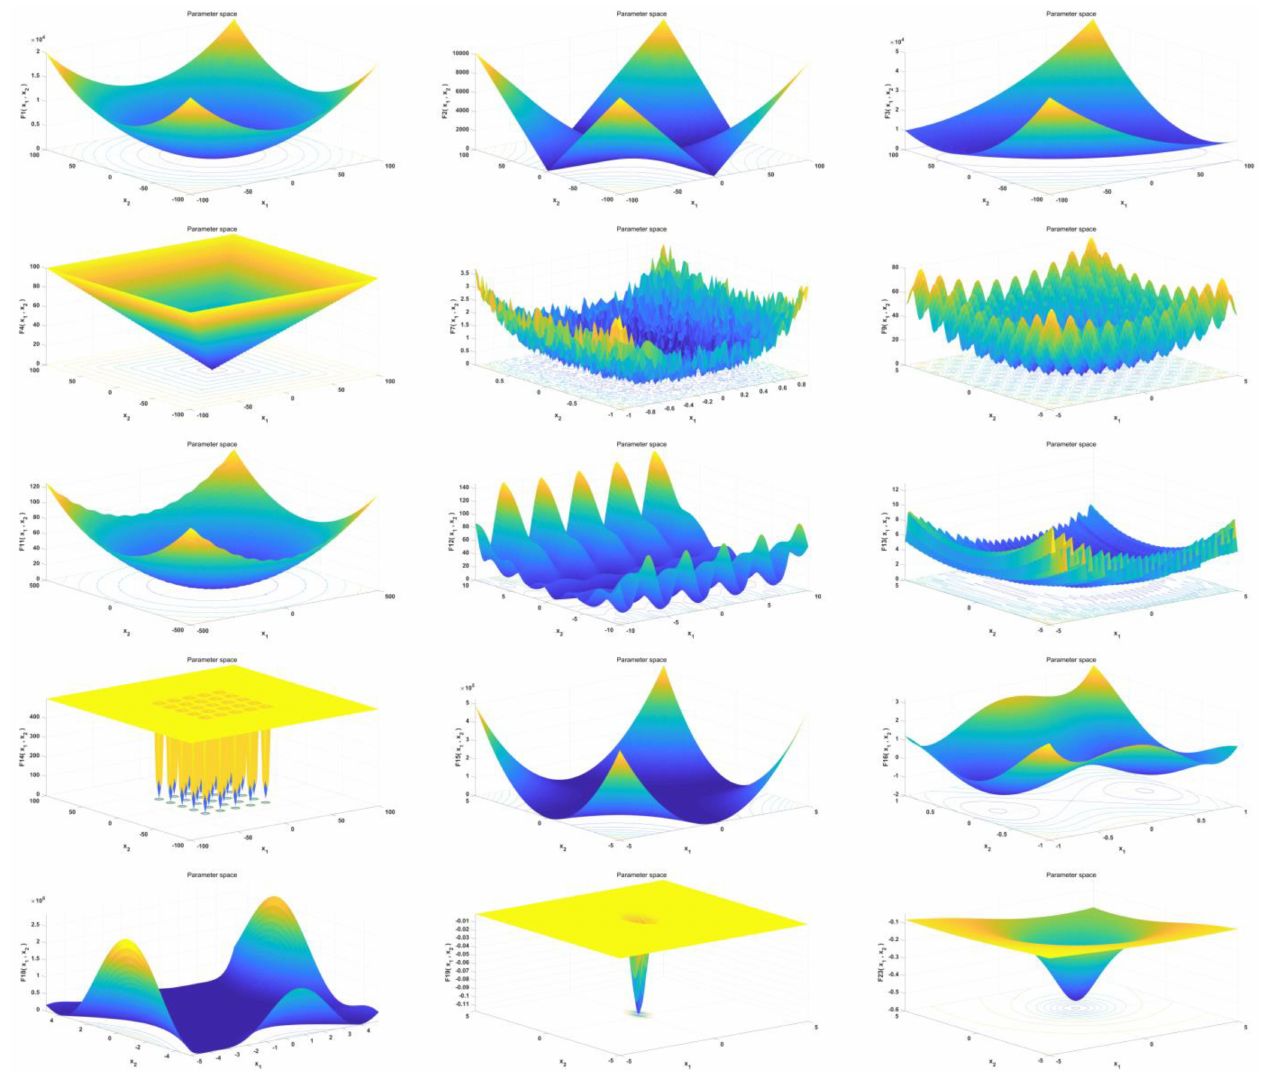
Figure 5. Fitness charts of 15 cases in two